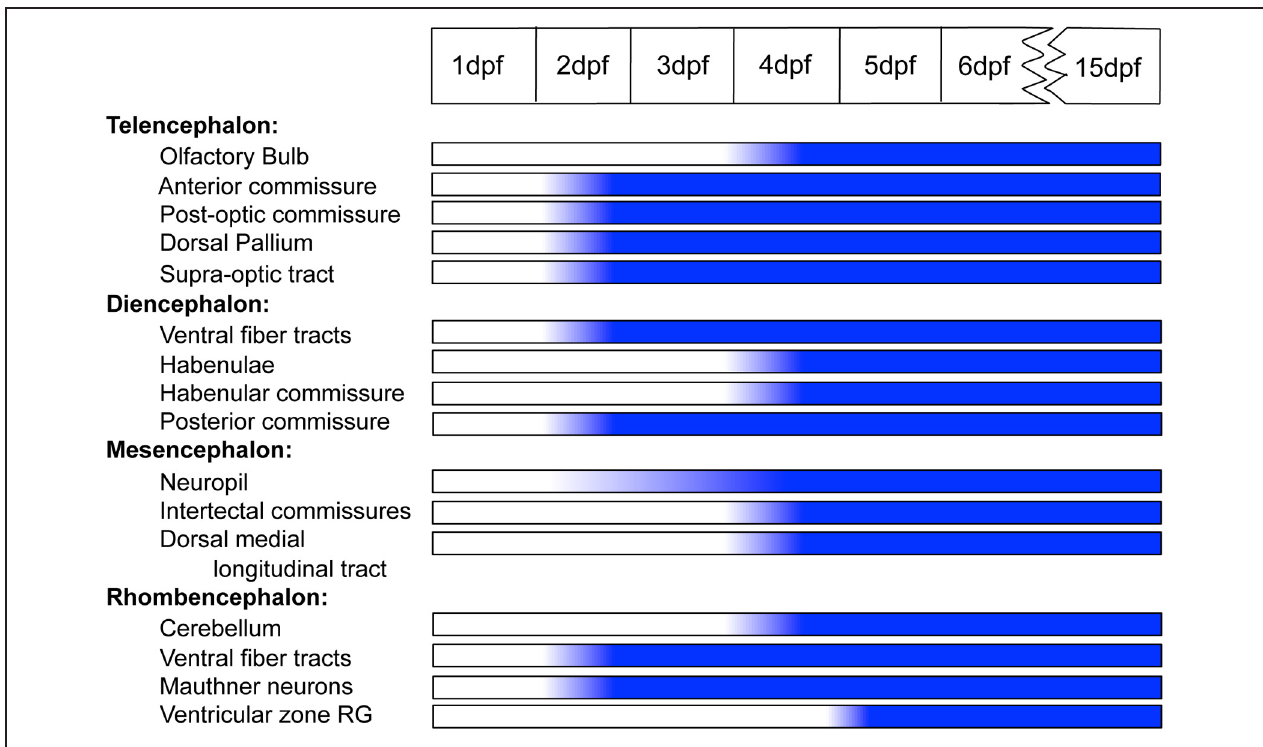
FIGURE 9 | Timeline showing the ontogeny of Cx35 immunoreactivity in the CNS of zebrafish from 1dpf through 15dpf. Abbreviations are as given in the